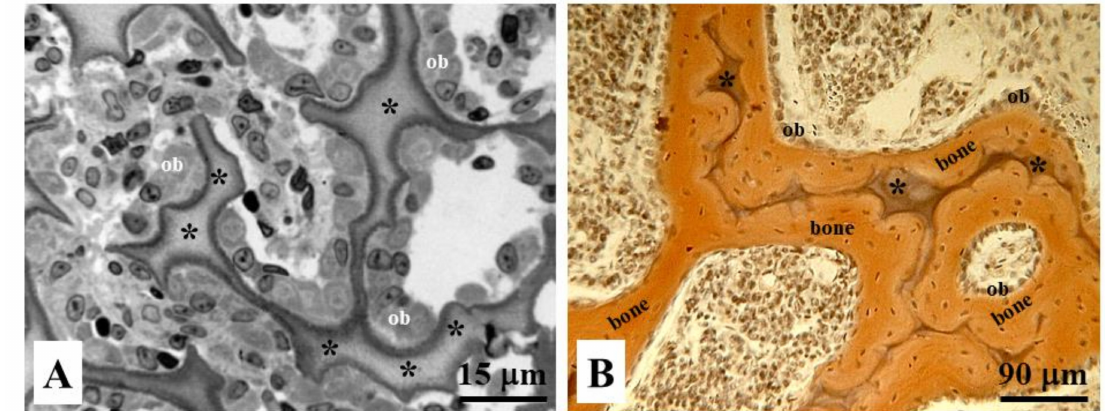
Figure 11. Histological sections of endochondral ossification in ( A ) osteoblastic laminae (ob) differentiated close to the remnants of calcified cartilage (asterisks), and in ( B ) bone deposition occurring through movable osteoblastic laminae forming and then compacting the primary haversian systems by dynamic